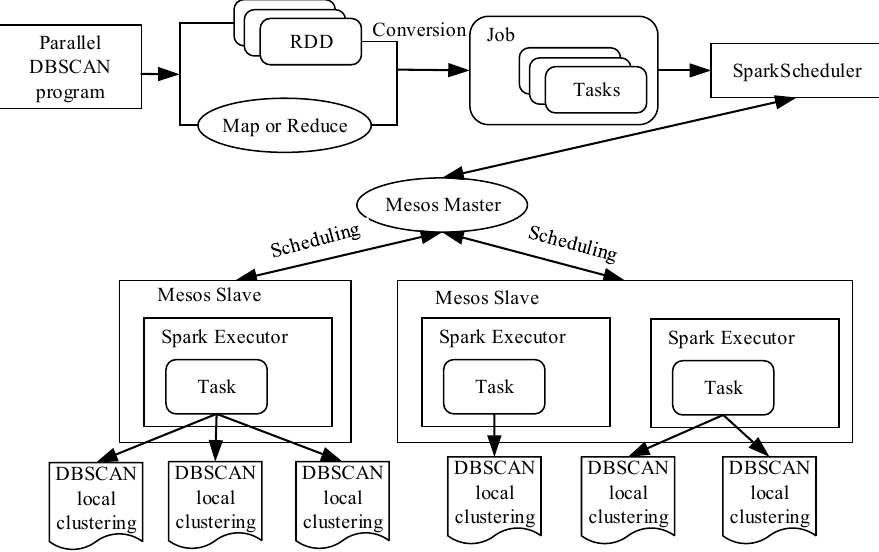
Figure 16. Parallel DBSCAN algorithm based on Mesos resource manager.